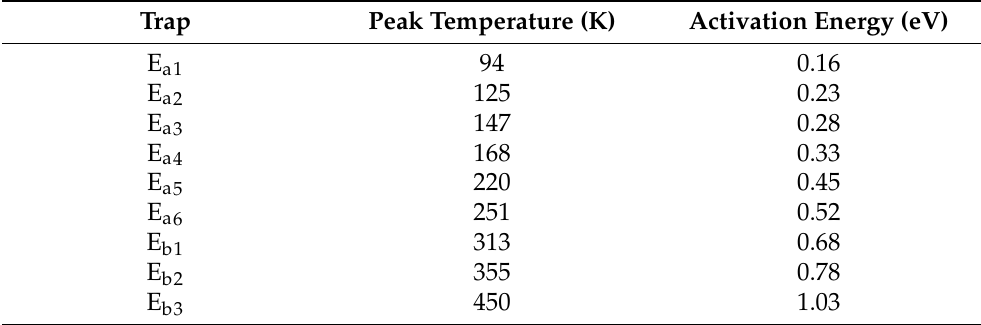
Table 1. List of traps and their activation energies in β -Ga 2 O 3 thin film using TSC